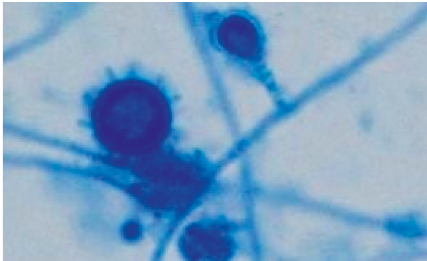
Figure 3: H. capsulatum mycelial phase macroconidia and microconidia (lactophenol cotton blue stain, 400x) from Sabour- aud dextrose agar plates incubated at 30 °